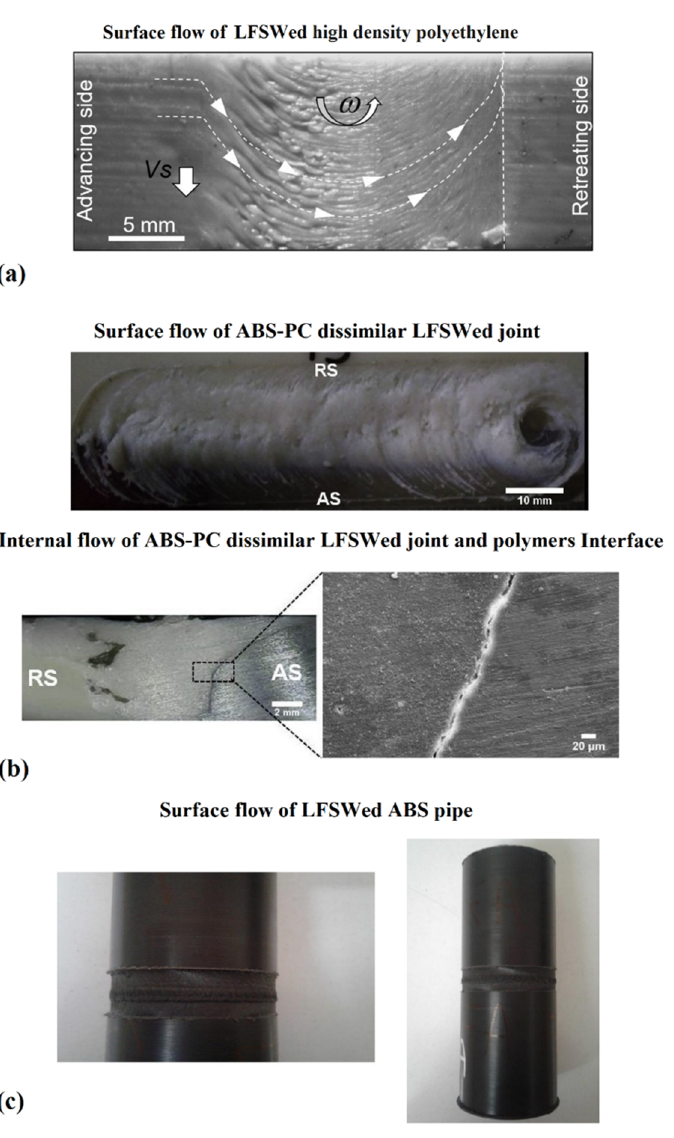
Figure 7. ( a ) Surface flow of high-density polyethylene (HDPE) joint after linear FSW (LFSW) [25], ( b ) surface and internal flow of ABS/PC dissimilar LFSW joint [27] and ( c ) digital image of HDPE pipe joint after LFSW [29].